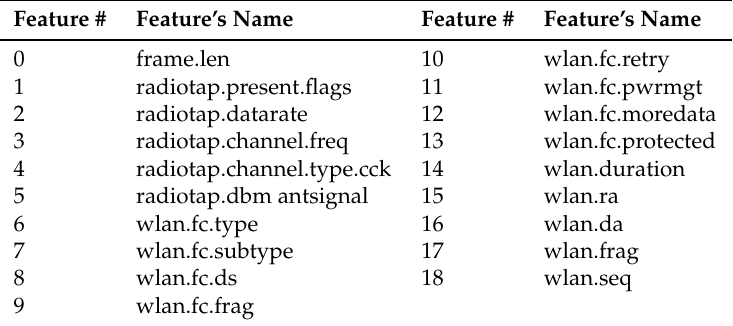
Table 5. Features selected for the first stage ML model.